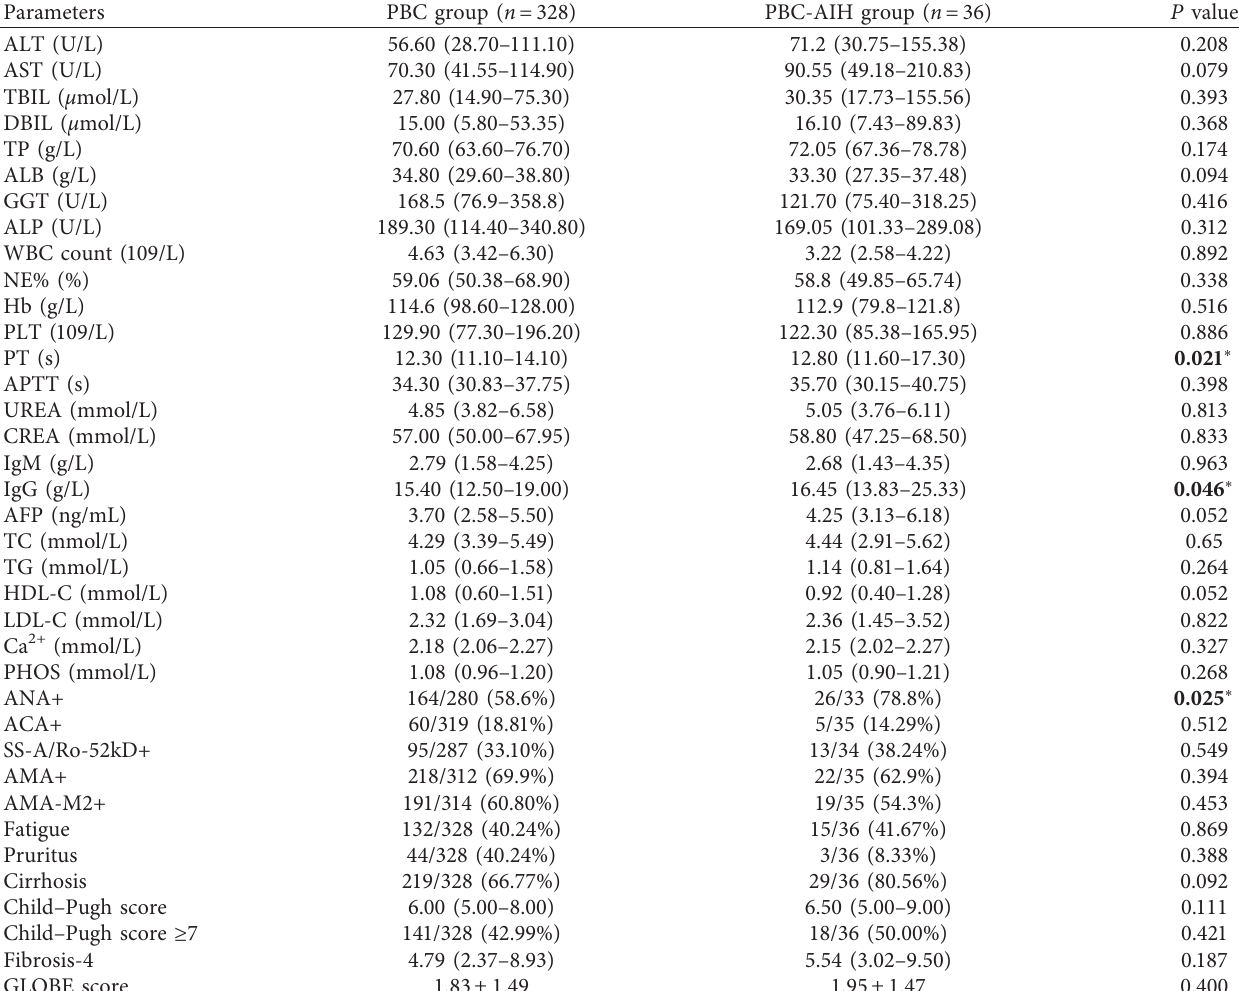
Table 3: Clinical features and laboratory results of patients with primary biliary cholangitis and those with primary biliary cholangitis complicated with autoimmune